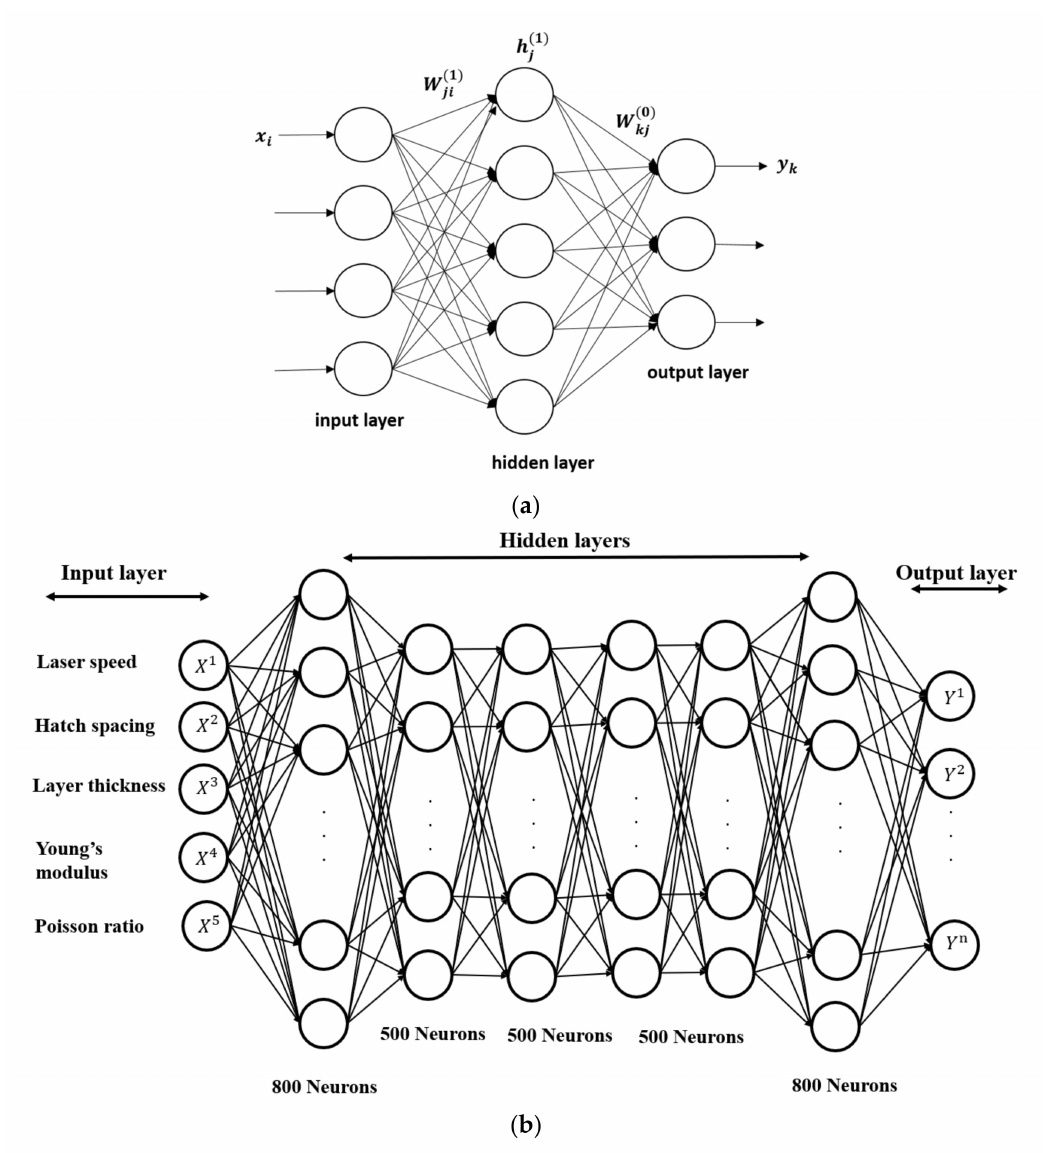
Figure 2. ( a ) Single layer neural network [33], and ( b ) six-layers deep neural network used in the present